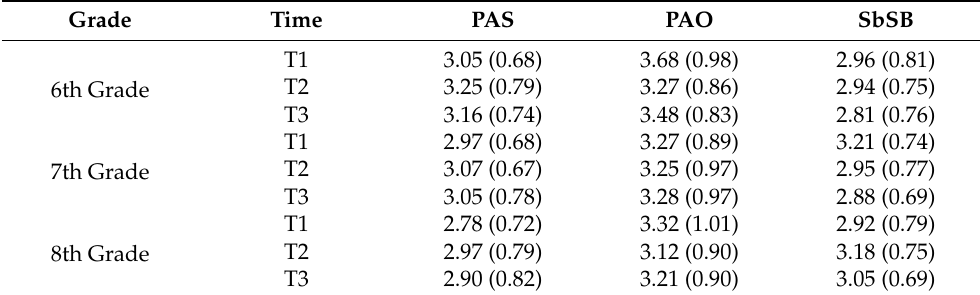
Table 3. Descriptive results for the behaviors by time and grade—M (SD).